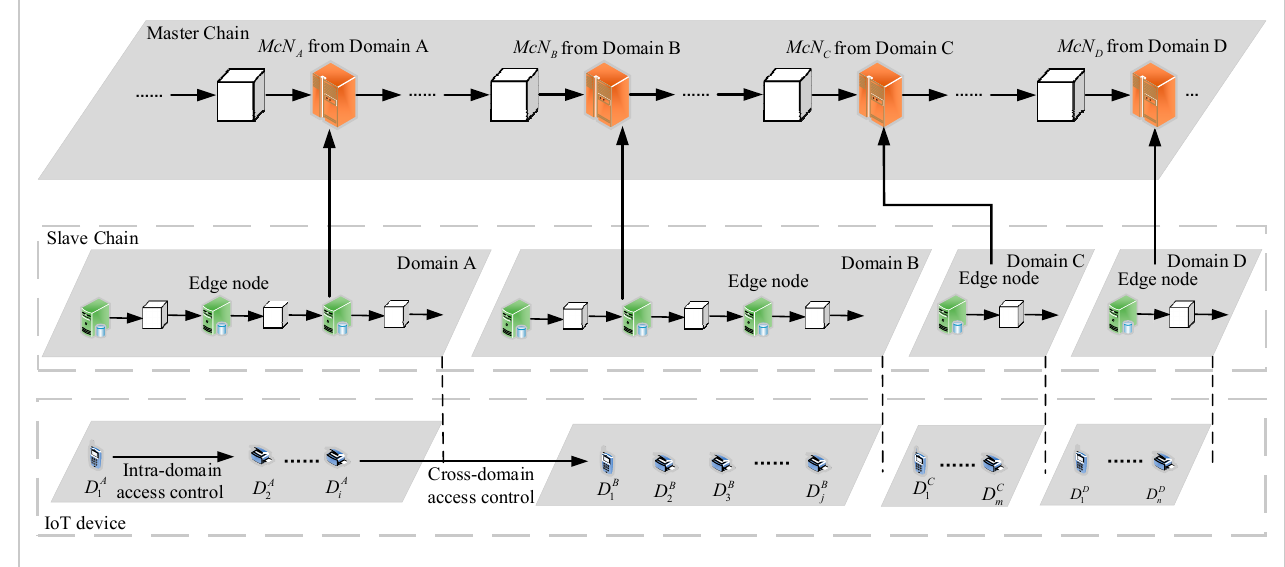
Figure 1. System architecture.